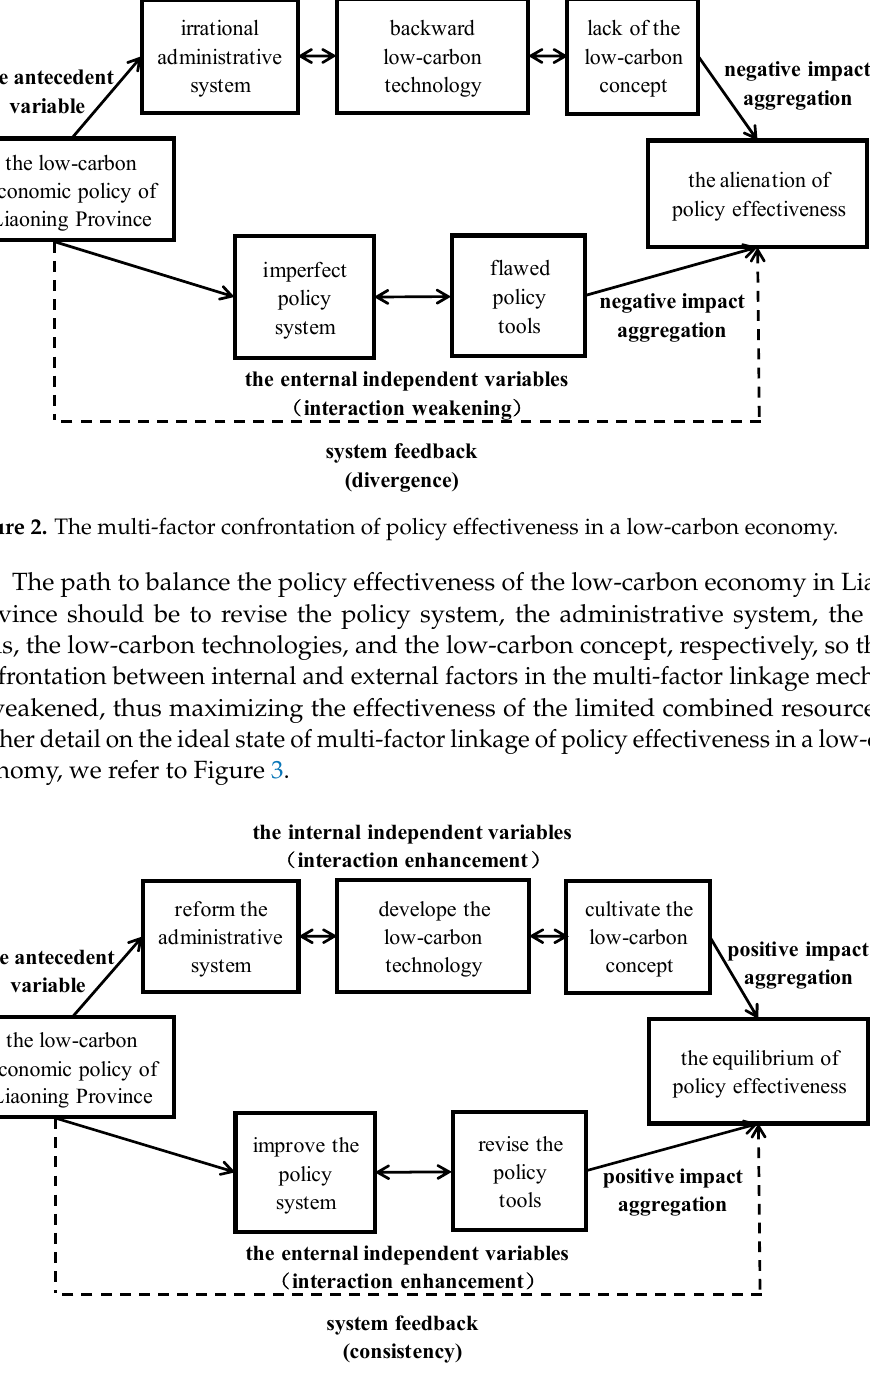
Figure 3. The ideal state of multi-factor linkage of policy effectiveness in a low-carbon economy.